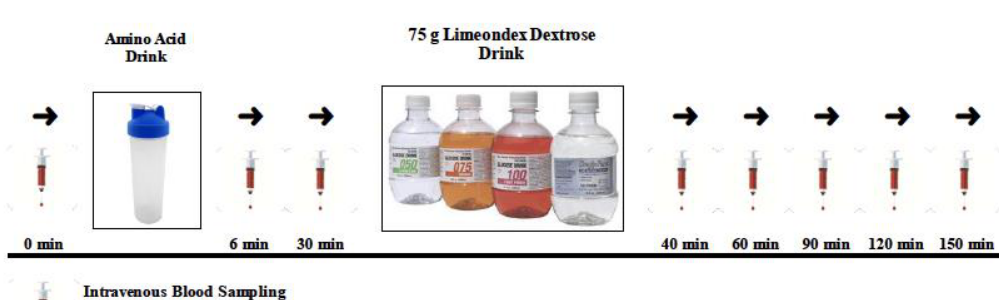
Figure 1. Schematic study design of intermittent intravenous sampling at baseline (0 min) to the end of the trial (150 min). Amino acid treatment (Ile, Leu, Ile + Leu, Pla) was consumed after baseline sample was taken. After 0–30 min of the amino acid only phase, dextrose (Limeondex) was consumed. Following dextrose consumption, samples were collected at 40–150 min.